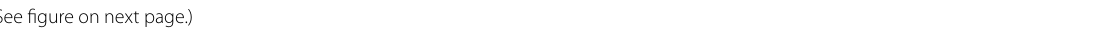
deviation(See figure on next Fig. 2 Individual differences in the type and strength of the early warning signal. The x-axis represents each EMA momentary state, the y-axis each transition. Note that four individuals had two transitions (denoted by digits, with the lowest digit corresponding to the first transition). EWS were detected using moving window analyses (window 2 weeks). To facilitate interpretation, the EMA momentary states were assigned to summary = categories based on hypothesized underlying constructs. A colored block indicates that the EWS was significant for that transition. The color intensity indicates the strength of the EWS: the more intense the color, the stronger the EWS. Strength of the EWS was operationalized as the value of Kendall’s tau. Abbreviations: AR autocorrelation at lag-1, EMA ecological momentary assessment, EWS early warning signal, sd standard =